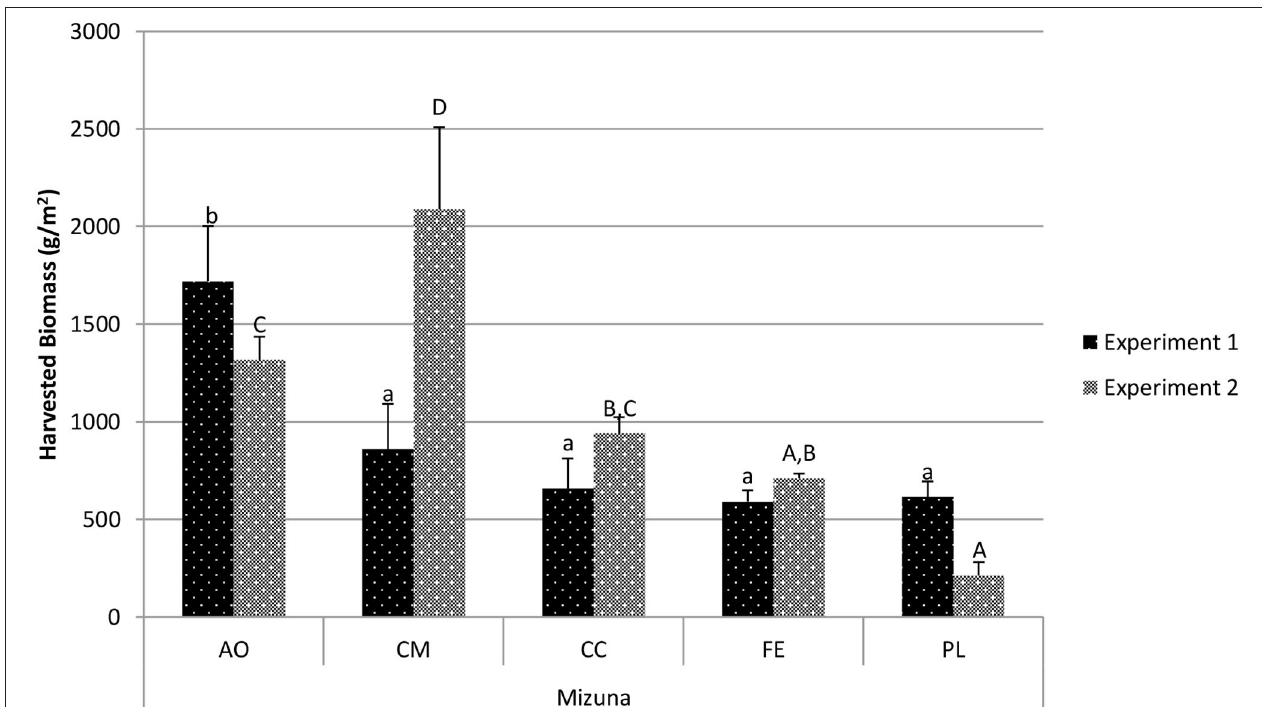
FIGURE 2 | Comparison of mizuna harvested biomass between treatments in experiment 1 and experiment 2. Data shown are mean ± standard deviation for two different replicate experiments. Significant differences among mean values are indicated with different letters above bars ( p < 0.05) with lower-case letters for experiment 1 and capital letters for experiment 2. Results analyzed using ANOVA Tukey HSD for significance